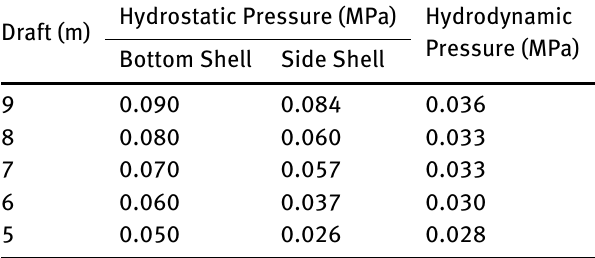
Table 7: Hydrostatic pressure and hydrodynamic pressure values for draft variations.